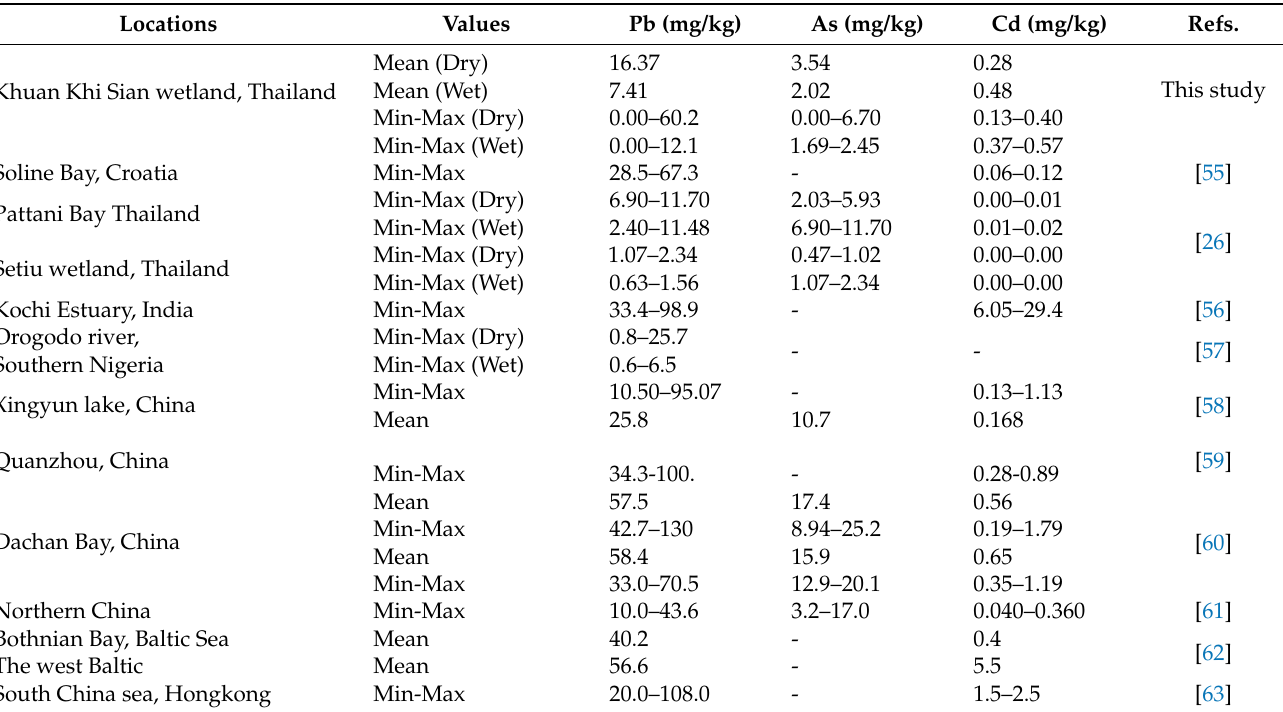
Table 5. Heavy metal concentrations (mg/kg) in sediment cores of the Khuan Khi Sian wetland compared to different parts of the